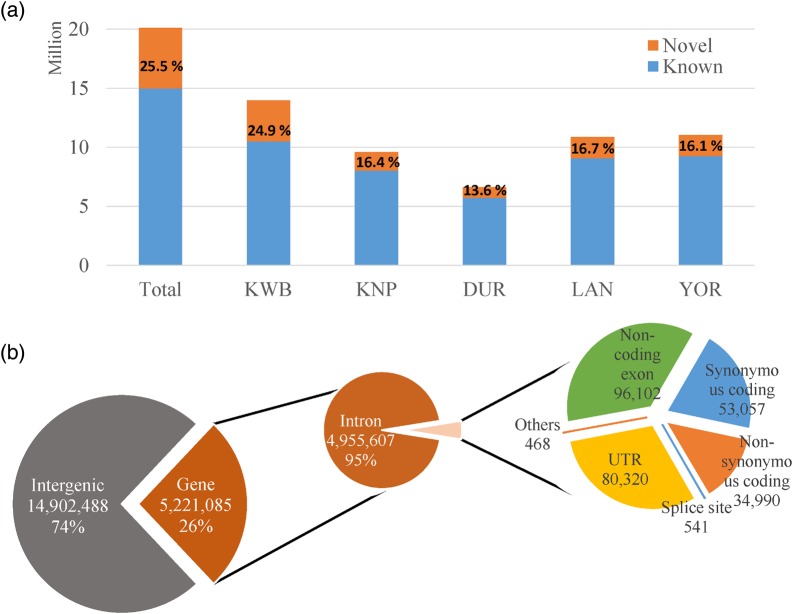
Overview of the identified SNPs. (a) The number of SNPs identified from 55 pigs of the five breeds used in this study (KWB, KNP, DUR, LAN, and YOR). (b) The pie chart showing functional categories of all the detected SNPs. In the functional categories, the ‘Others’ represents the sum of three functional categories including ‘start lost’, ‘stop gained’, and ‘stop lost’. This figure is available in black and white in print and in colour at DNA Research online.